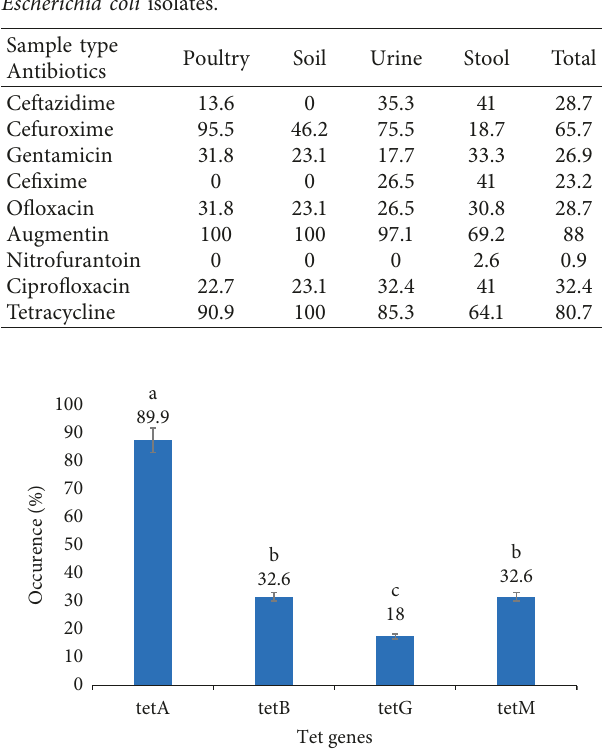
Figure 1: Percentage occurrence of tetracycline-resistant genes from all isolates.